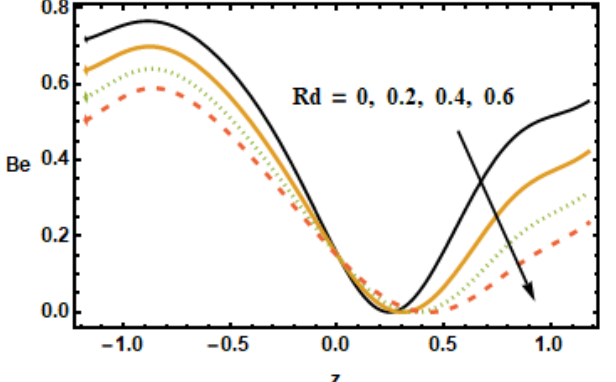
Figure 28. Effects of radiation parameter Rd on Be . Figure 27. Effects of volume fraction Figure 27. Effects of volume fraction φ on Be .